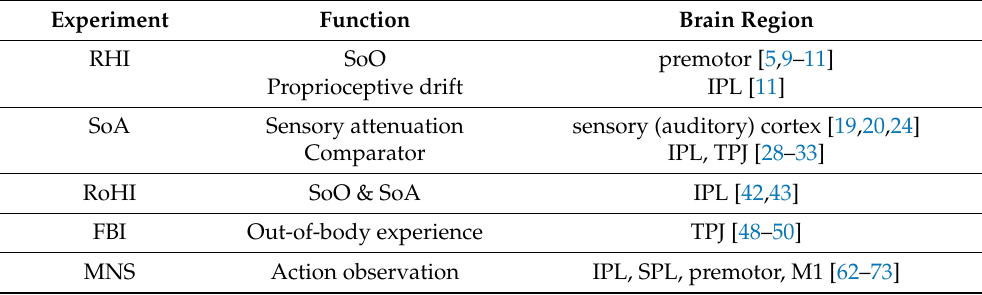
Table 1. Brain regions involved in self-body recognition and